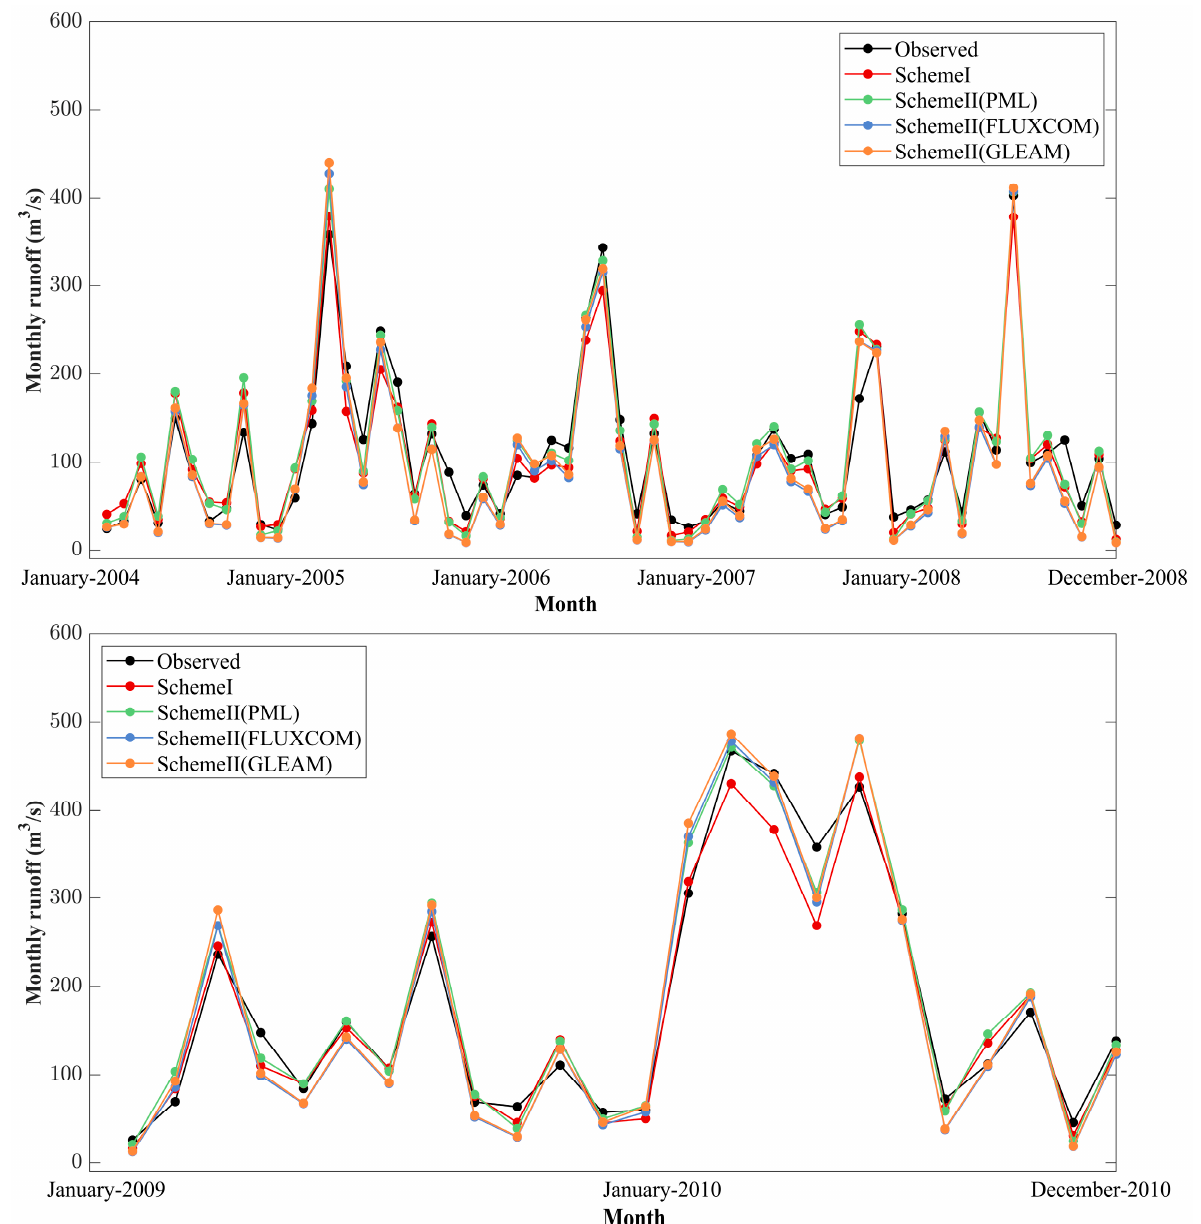
Figure 8. Comparison of observed and simulated monthly runoff in the calibration and validation periods based on Scheme I and Scheme II.